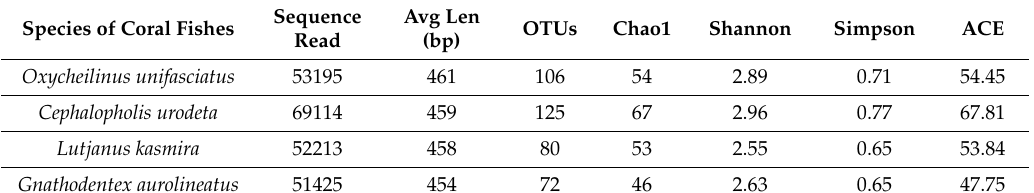
Table 1. Comparison of microbial sequences, the estimated operational taxonomic units (OTUs) richness, Shannon’s indexes of the microbial 16S V4 sequences for clustering at 97% sequences similarity from the sequencing analysis.